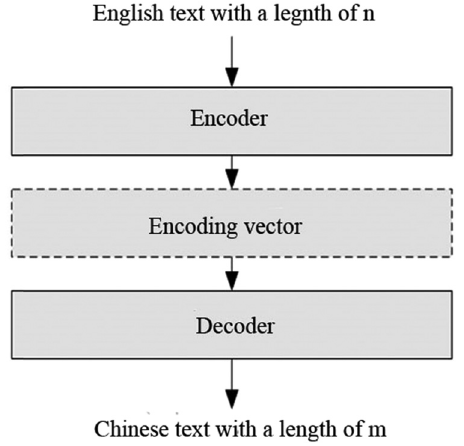
Figure 2: Basic structure of deep learning - based machine translation